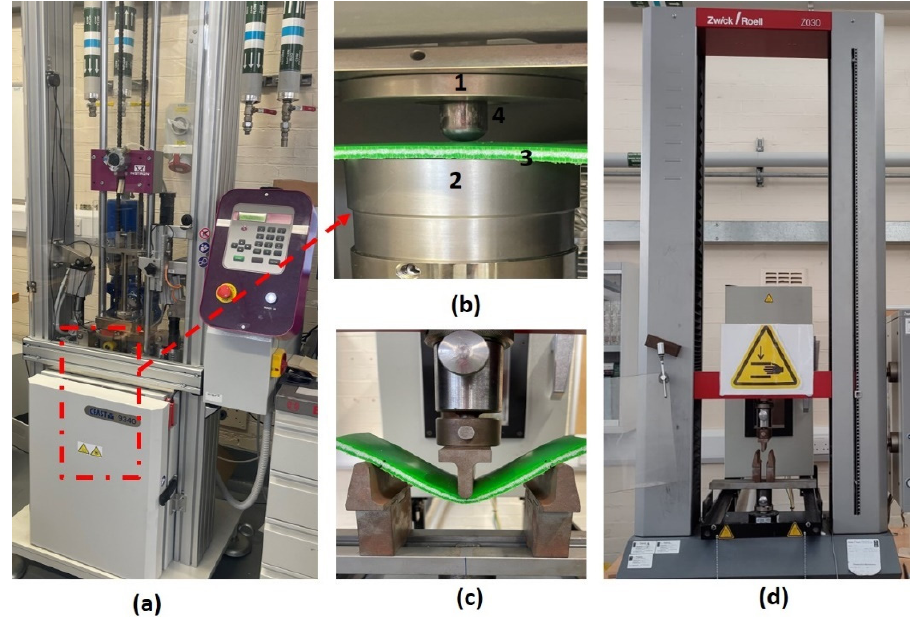
Figure 2. Testing equipment and set-up; ( a ) low-velocity impact testing machine, ( b ) impact testing sample holder arrangement (1 and 2—upper and lower parts of the sample holder, respectively; 3—sandwich specimen; 4—impactor nose), ( c ) three-point bending set-up with sandwich specimen for flexure-after-impact (FAI) test, and ( d ) FAI test